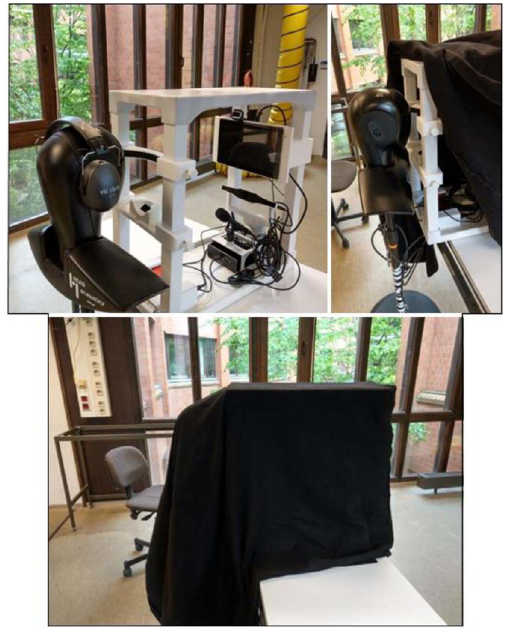
Figure 2. MASAVE with simulated subject without textile cover (top left), with textile covering the MASAVE structure (top right), and with textile covering the MASAVE and the entire torso to block out light